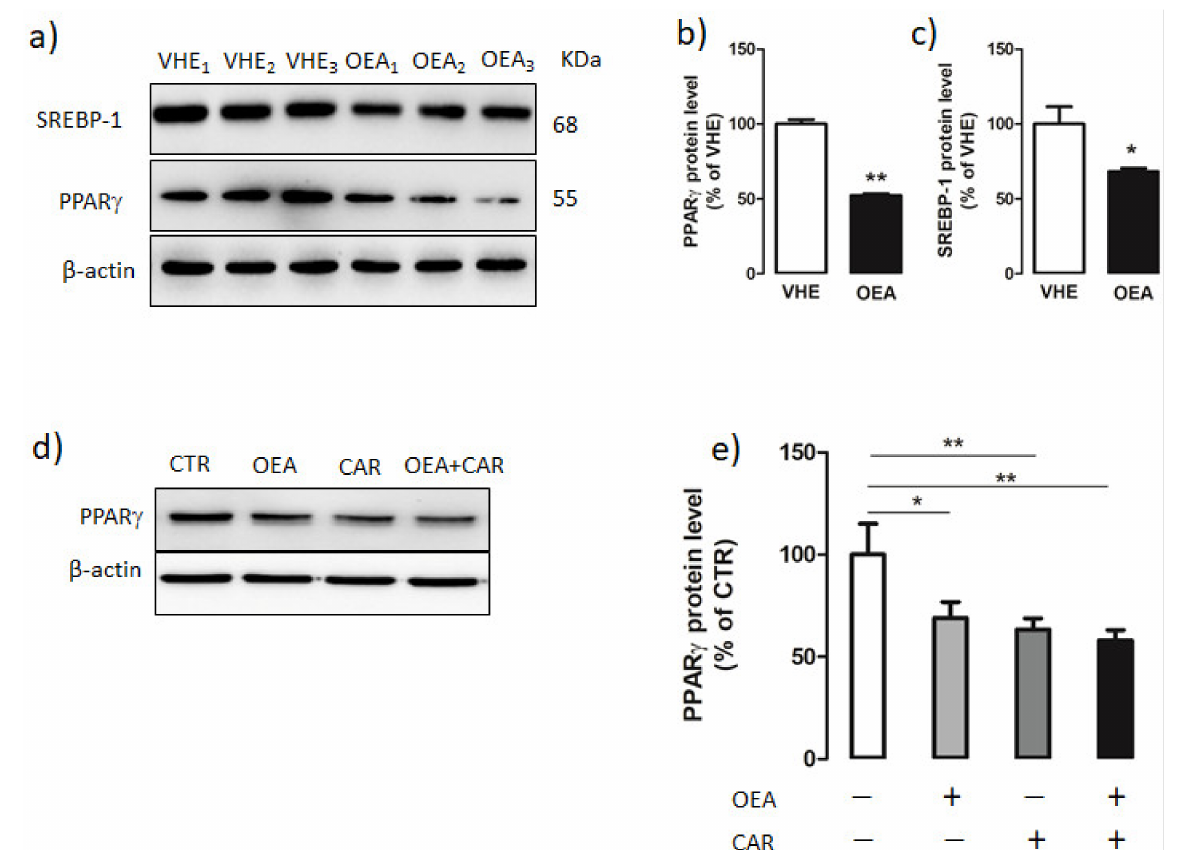
Figure 5. Hepatic PPAR γ and SREBP-1 protein expression. ( a ) Hepatic proteins from VEH- and OEA-treated rats were subjected to SDS-page electrophoresis. Membranes were then subjected to immunoblotting using specific antibodies for sterol regulatory binding protein-1 (SREBP-1) and peroxisome proliferator-activated receptor γ (PPAR γ ). ( b , c ) Signals were quantified by densitometric analysis and expressed as percent of the vehicle (VHE). ( d , e ) PPAR γ expression in HLF cells treated for 2 h with 10 µ M OEA, 5 µ M Carmofur (CAR) and OEA + Carmofur. β -actin was used as the loading control. Blot signals were quantified by densitometric analysis and reported as % of control (CTR) which was represented by cells without any treatment. Values are the mean ± SEM of five different experiments. * p < 0.05; ** p <